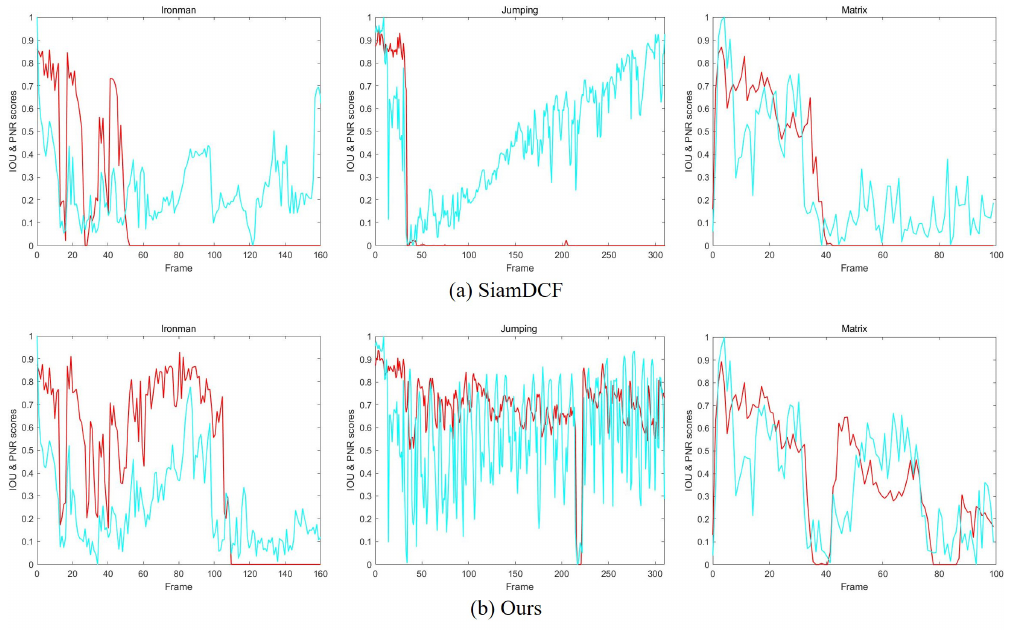
Figure 5. Visualization of the tracking result on three benchmark datasets including ( Ironman , Jumping , and Matrix ). ( a ) is a response graph of SiamDCF; and ( b ) is a response graph of ours. Red curves represent the IoU score of an estimated target and the ground-truth, while Green curves represent the normalized PNR value of the correlation response. Unlike the ( a ), the PNR graph of ( b ) is similar to that of IoU. This shows that the correlation filter can learn the robust features of the target online through the attention map generated from the structure–attention